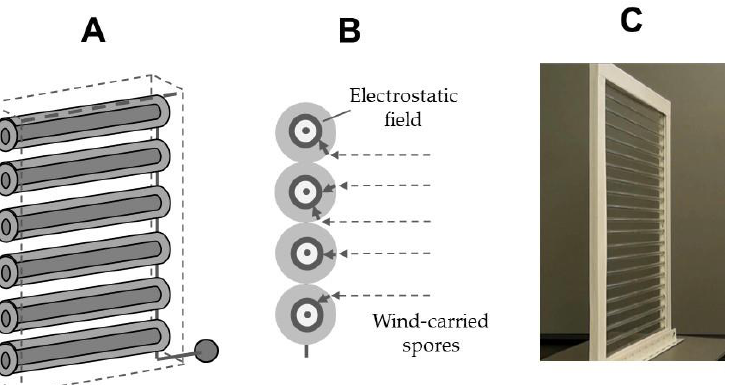
Figure 4. ( A ) Vertically arrayed insulated conductor wires (ICWs); ( B ) air-shielding barrier of connected electrostatic fields comprising vertically arrayed ICWs (cross-sectional view); and ( C ) single-charged monopolar electric field screen.